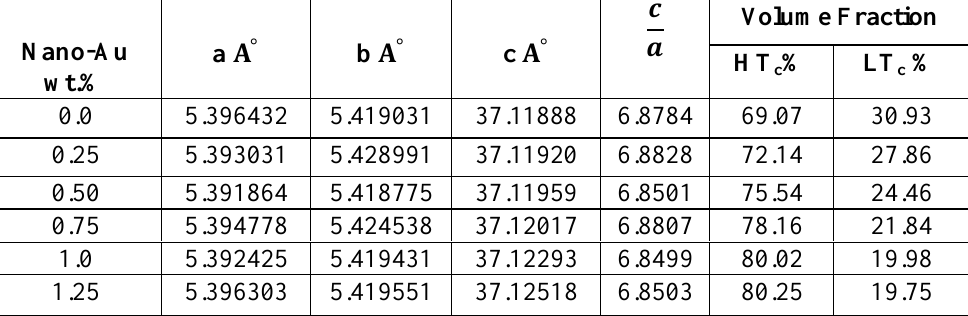
Fig.1: X-Ray diffraction patterns of (Au) 0.75, 1.0, and 1.25 wt%) Table 1: Lattice parameters and phase volume fraction of (Au) samples for different Au nanoparticles weight